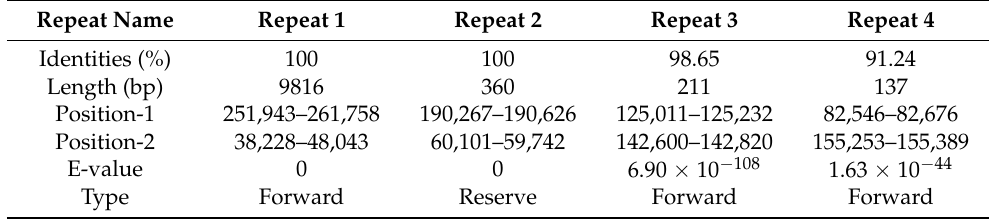
Table 2. List of four repeat sequences mediated homologous recombination in the mitogenome of G. elegans